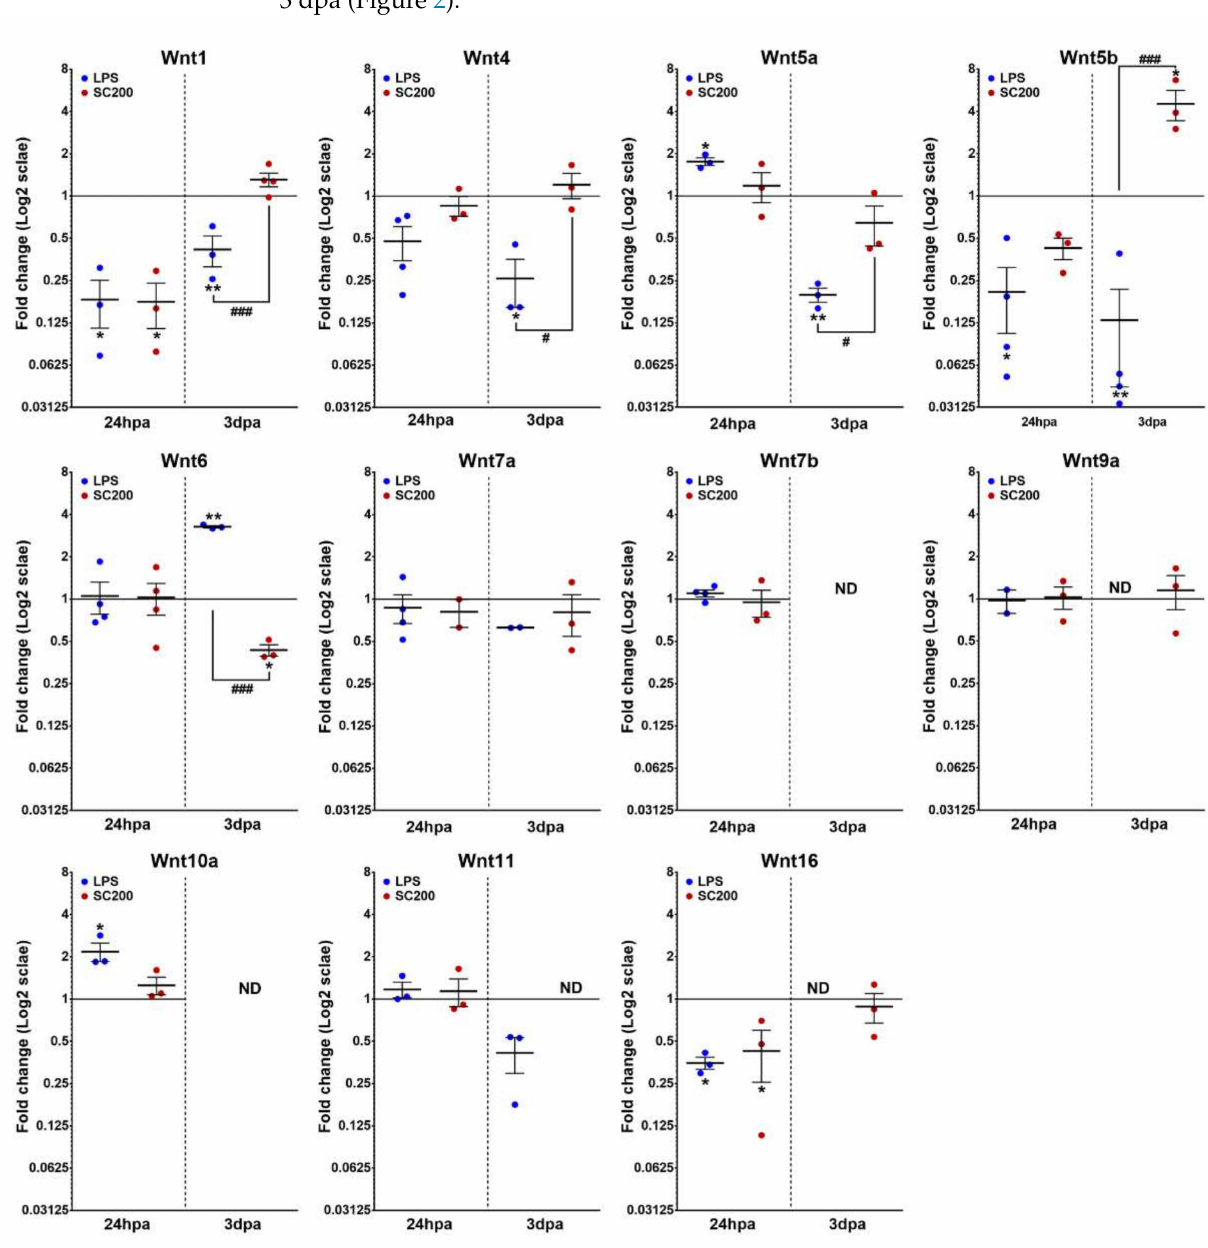
Figure 2. mRNA expression analysis of Wnt ligands in LPS- or SCE-activated microglia and compared to non-activated basal conditions. The figure shows mRNA expression data corresponding to different detectable Wnt ligands in activated microglial cells either with 100 ng/mL of lipopolysaccharide (LPS) or with 200 µ g/mL of lesioned spinal cord extract (SCE). Data represent 2 ∆∆ Ct mean ± SEM. * indicate differences between treated cells vs. non-activated. # indicate differences between treatments (LPS vs. SCE). * p < 0.05; ** p < 0.01; *** p < 0.001; # p < 0.05; ## p < 0.01; ### p < 0.001. hpa: hours post-activation; dpa: days